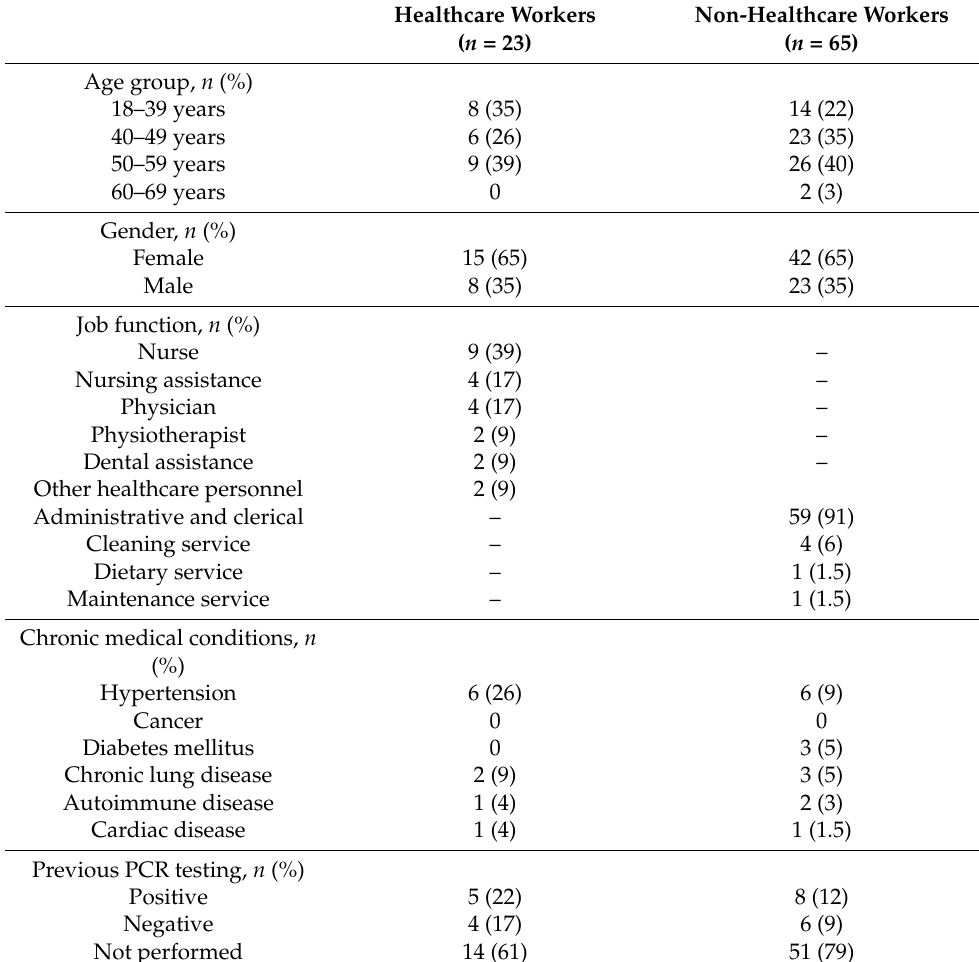
Table 2. Characteristics of healthcare workers and non-healthcare workers who had detectable neutralizing